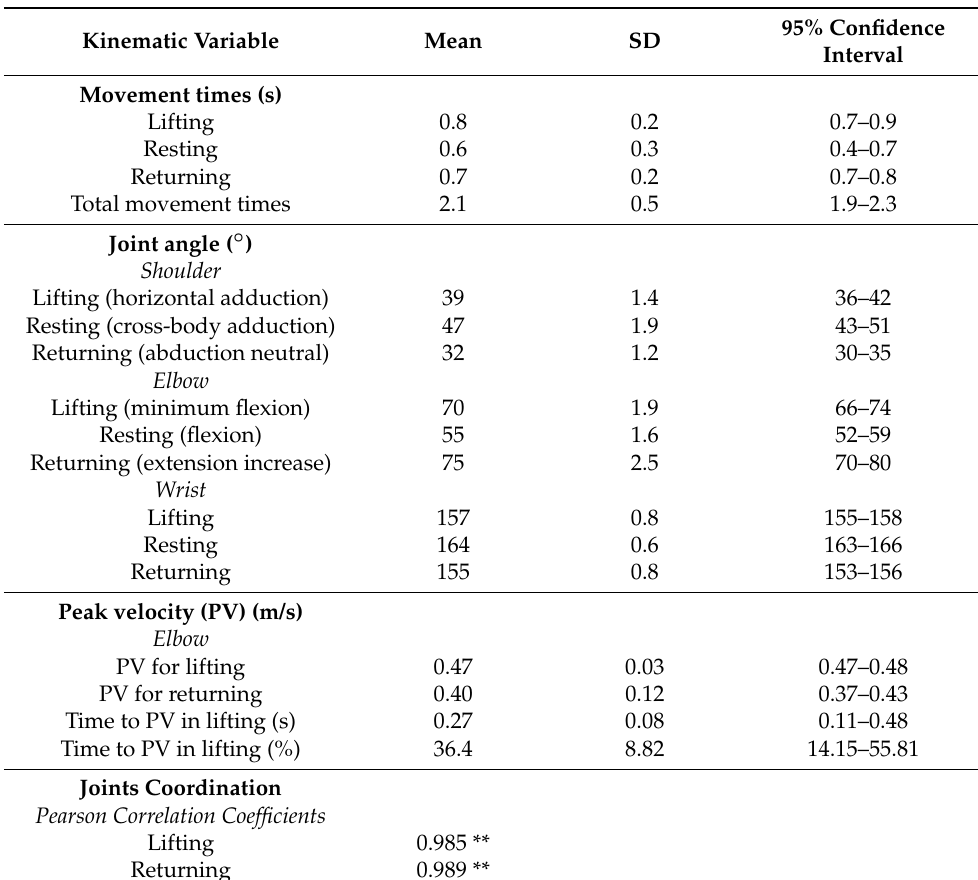
Table 2. Kinematic variables for all